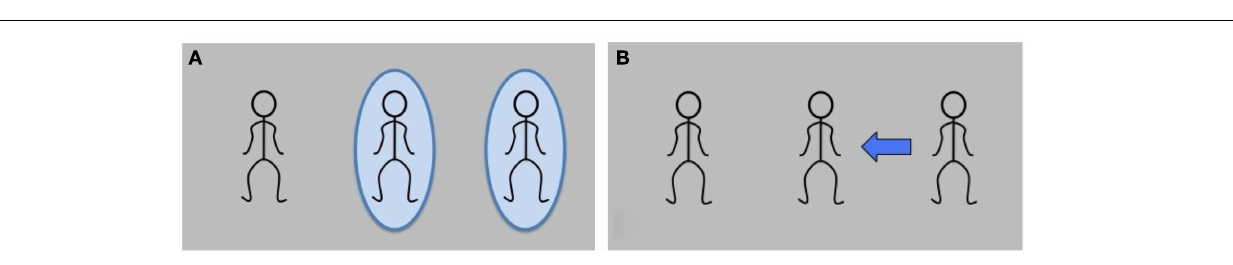
and right character). Before initiating the sentence, she shifted her gaze back to the middle character (the NP1 referent) and stayed there as she uttered the first noun phrase (mean speech onset: 6870 ms after video onset). Shortly after uttering the verb and before the second noun phrase, the speaker’s gaze shifted from the NP1 referent to the NP2 referent (shift onset: M = 949 ms after verb onset; M = 740 ms before NP2 onset). She looked back into the camera at the end of the sentence (total duration of the video: M = 13,143